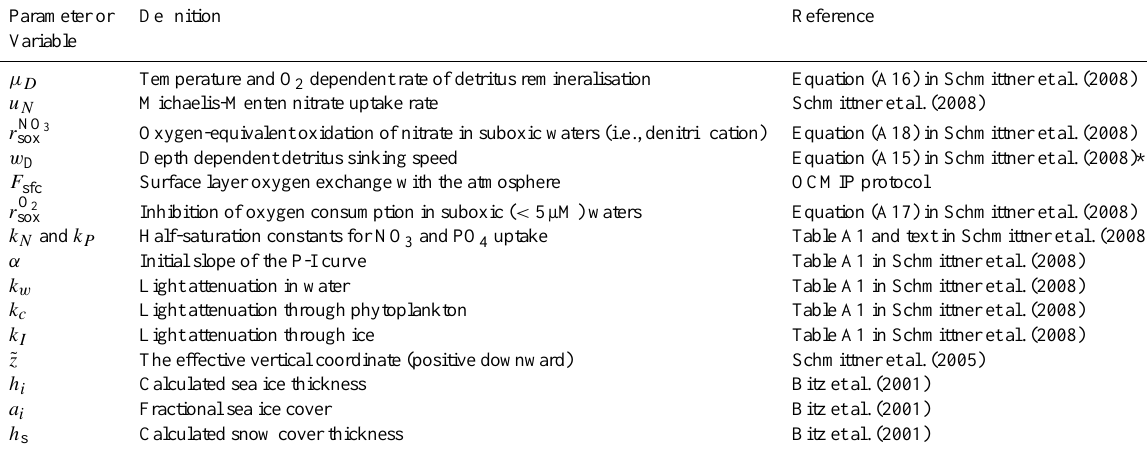
Table 2. Definitions of parameters and variables that are not specifically mentioned in the text.